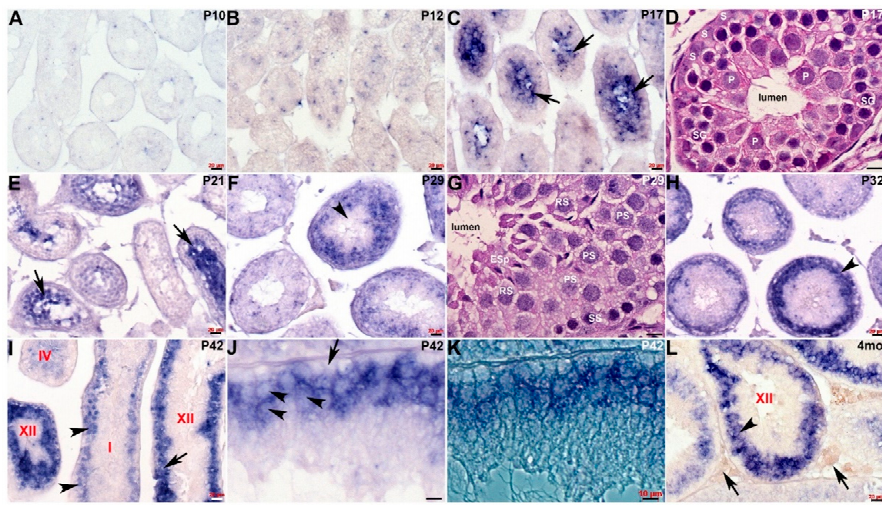
Figure 2. Spatiotemporal analysis of Cracd expression. ( A – C ) Non-radioactive in situ hybridization detection of Cracd mRNA (blue/purple precipitate) in staged postnatal mouse testis revealed very limited expression at P10 ( A ) and P12 ( B ), but a significant increase in levels within the innermost region in P17 seminiferous tubules ( C , arrows). ( D ) Hematoxylin-eosin stained sections reveal that P17 seminiferous tubules contain mainly peripheral Sertoli cells ( S ) and spermatogonia, with spermatocytes in the pachytene stage (P) occupying most of the inner layer around the lumen. ( E ) In testis cross-sections showing a number of seminiferous tubules at di ff erent epithelial stages, Cracd continues to be expressed in inner regions at P21 ( E , arrows). ( F ) However, thereafter there is a shift in site of Cracd expression to the periphery of the mature P29 seminiferous tubules, and Cracd is no longer expressed in inner cells ( F , arrowhead). ( G ) Hematoxylin-eosin stained sections reveal that Cracd is expressed in P29 tubules in mainly peripheral primary (PS) and secondary spermatogonia (SS) and round spermatids and is absent from the inner elongating spermatids (ESp). ( H – L ) In P32 ( H ), P42 ( I – K ) and 4-month-old